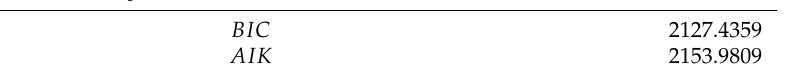
Dependent variable: IPI manufacture of coke and refined petroleum products ( 0,1,1 )( 0,1,1 ) 12 nolog